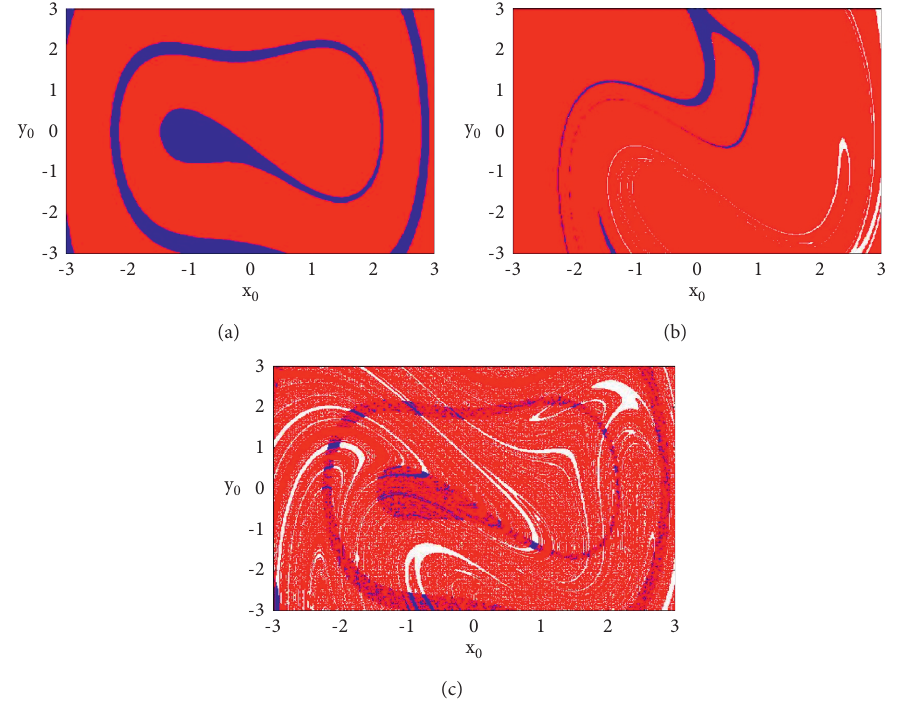
Figure 2: Basins of attraction of the new parametric chemical system (1) with the parameters of Figure 1 for three different values of f : (a) f � 0 . 03, (b) f � 2, and (c) f �